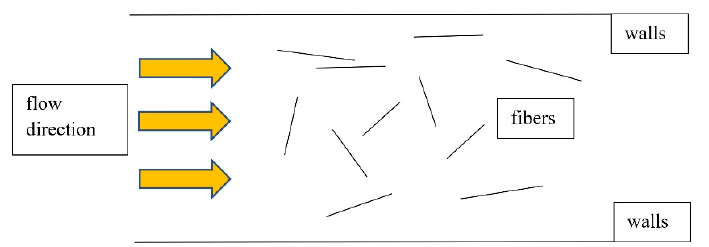
Figure 6. Monitoring of fibre orientation during fibre reinforced concrete creep.